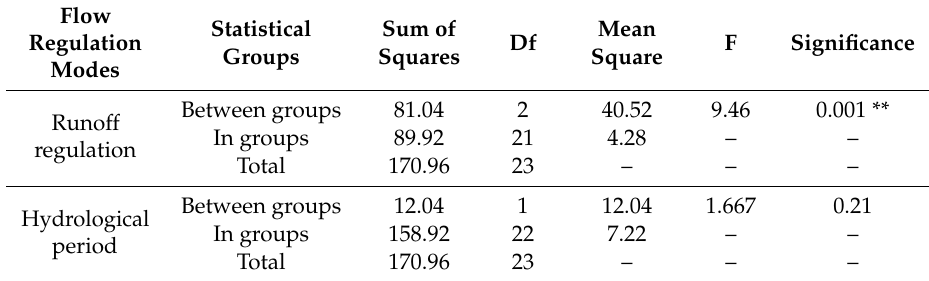
Table 2. One-way analysis of variance (ANOVA) results for macroinvertebrate abundance under two flow regulation modes (Runoff regulation and hydrological period) for Nan River (NR).